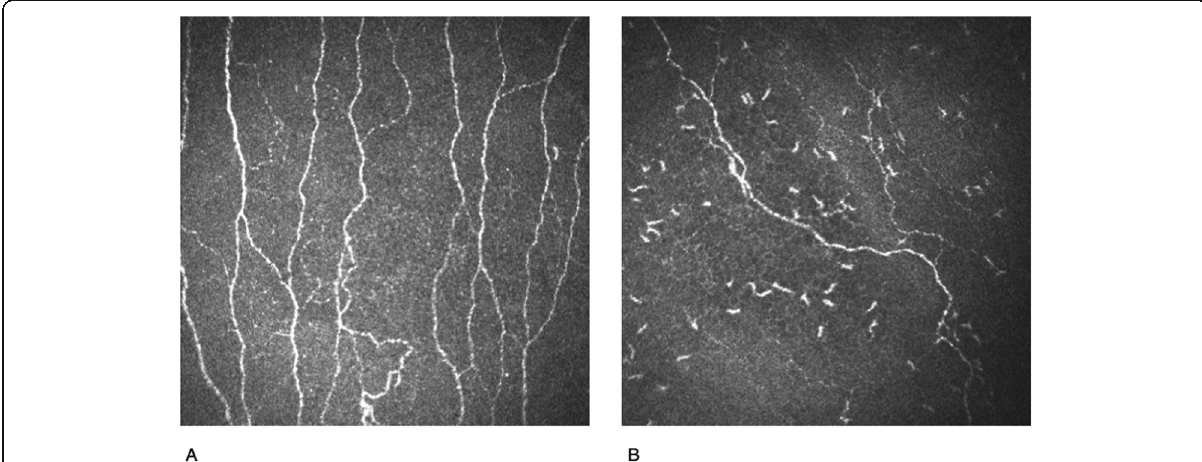
Fig. 3 Corneal confocal microscopy showing nerve fiber reduction and immune cell infiltration in a CIDP patient with progressive disease course ( b ) compared to a healthy person ( a ). (With the kind permission of Professor Martin Tegenthoff, Bochum, and Dr. Dietrich Sturm, Wuppertal,